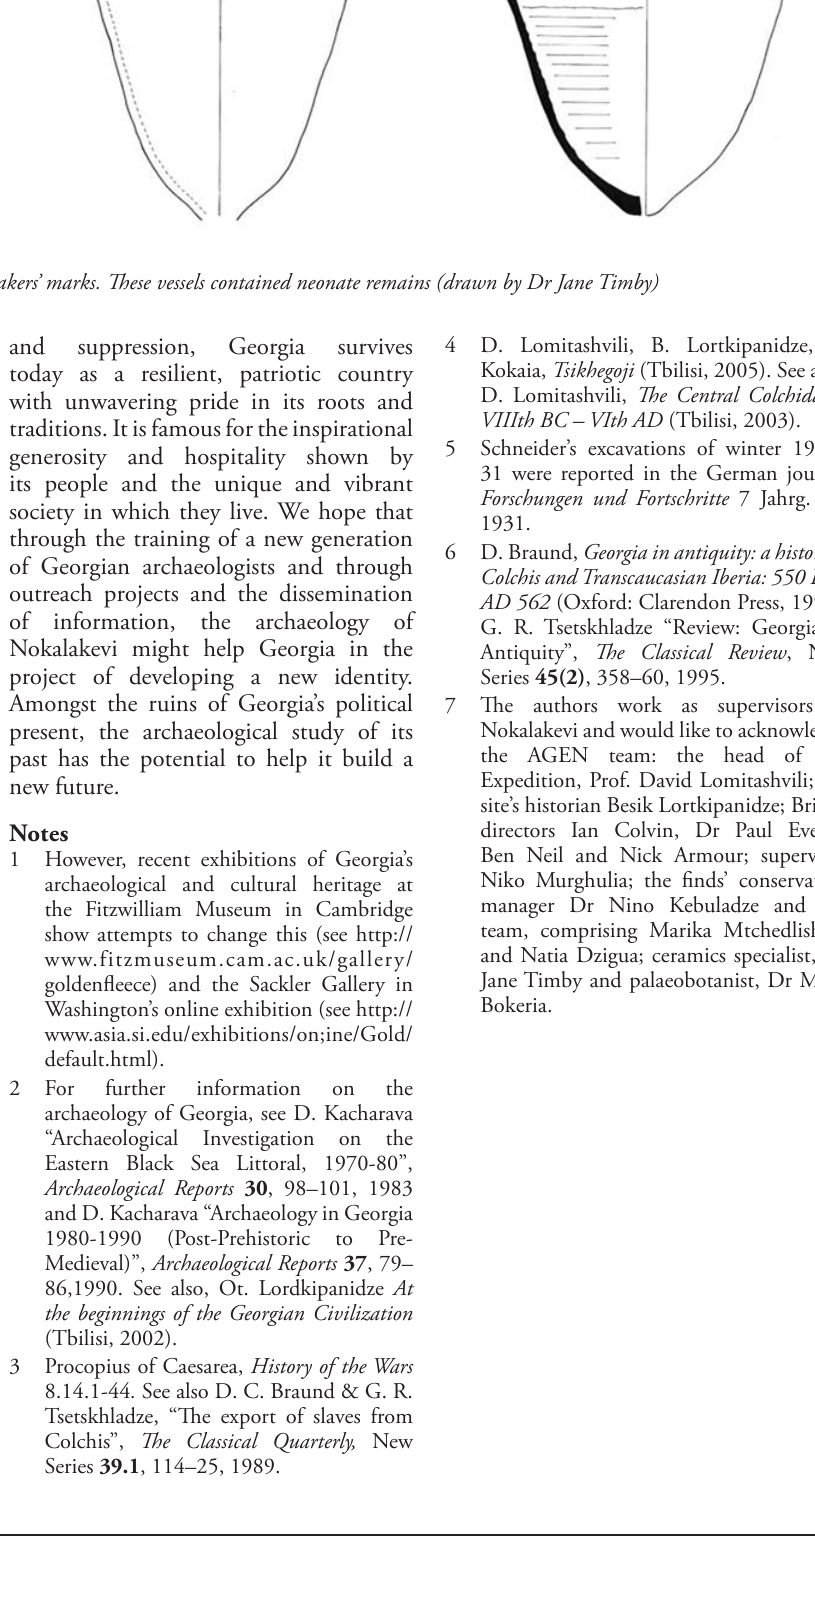
Figure 8 Restored amphorae showing inscribed makers’ marks. These vessels contained neonate remains (drawn by Dr Jane Timby)